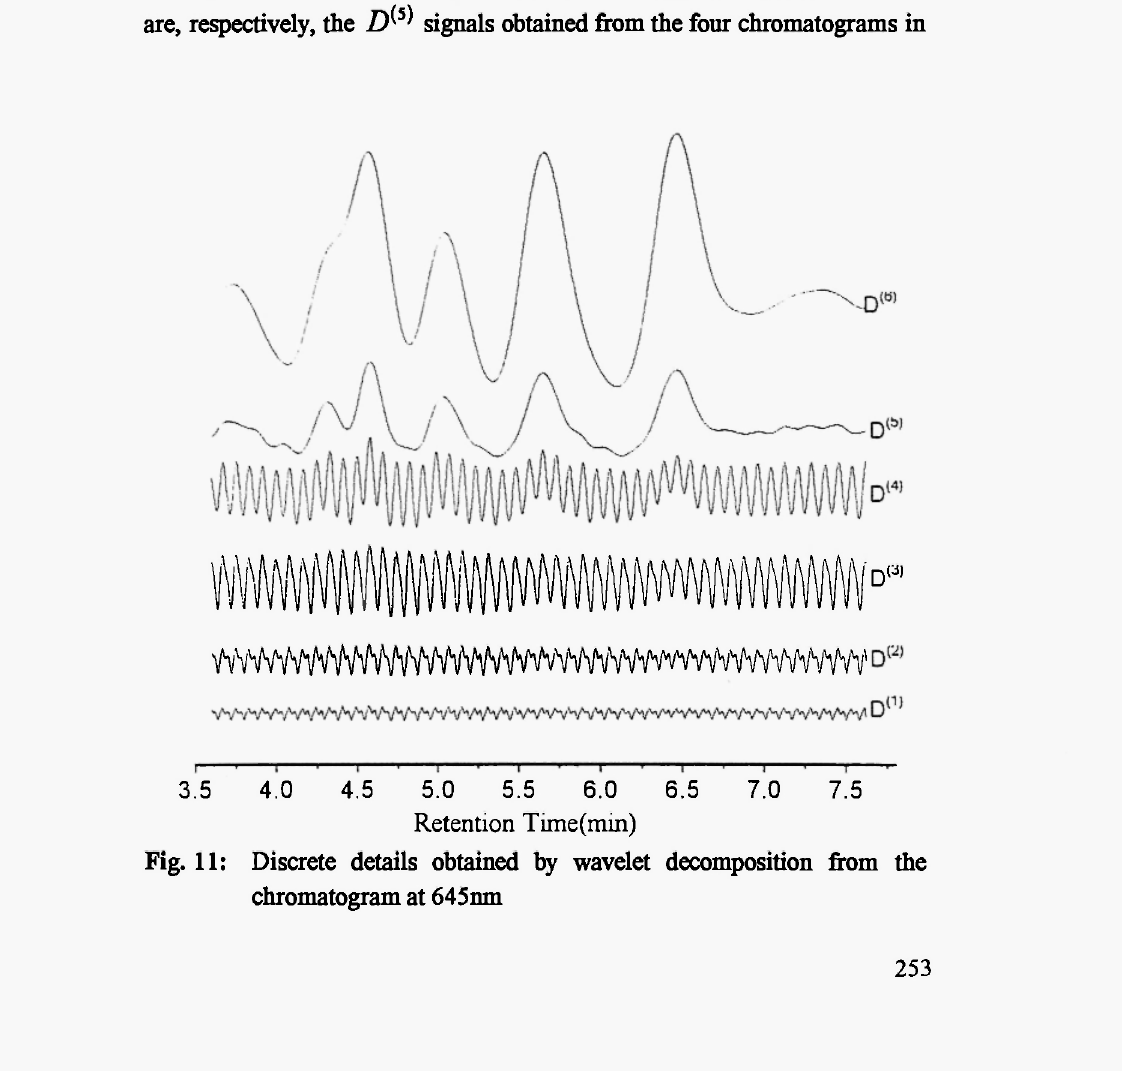
Fig. 11: Discrete details obtained by wavelet decomposition from the chromatogram at